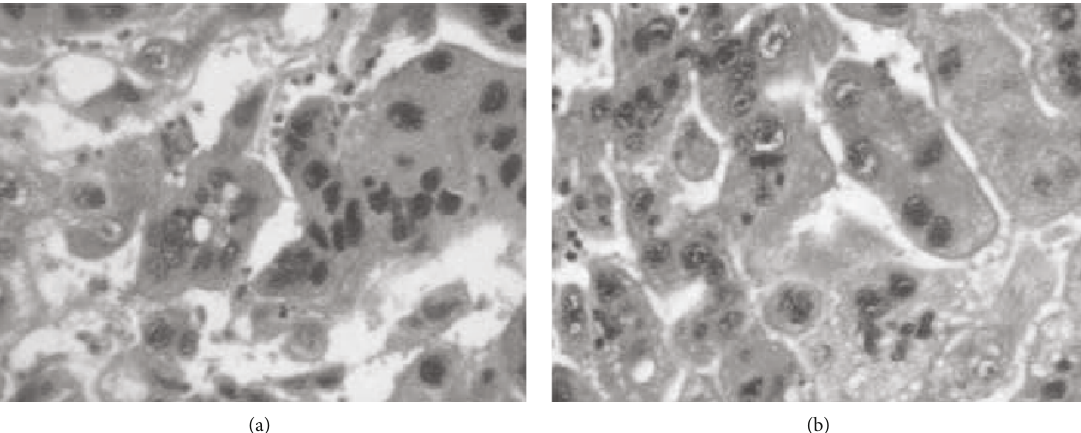
Figure 2: Microscopic section showing highly pleomorphic trophoblast cells with irregular, hyperchromatic prominent nuclei and mitotic activity with areas of extensive hemorrhage (a and